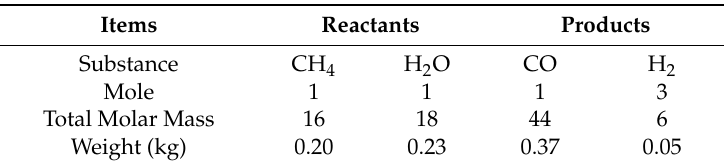
Table 3. Steam-methane reforming reaction.